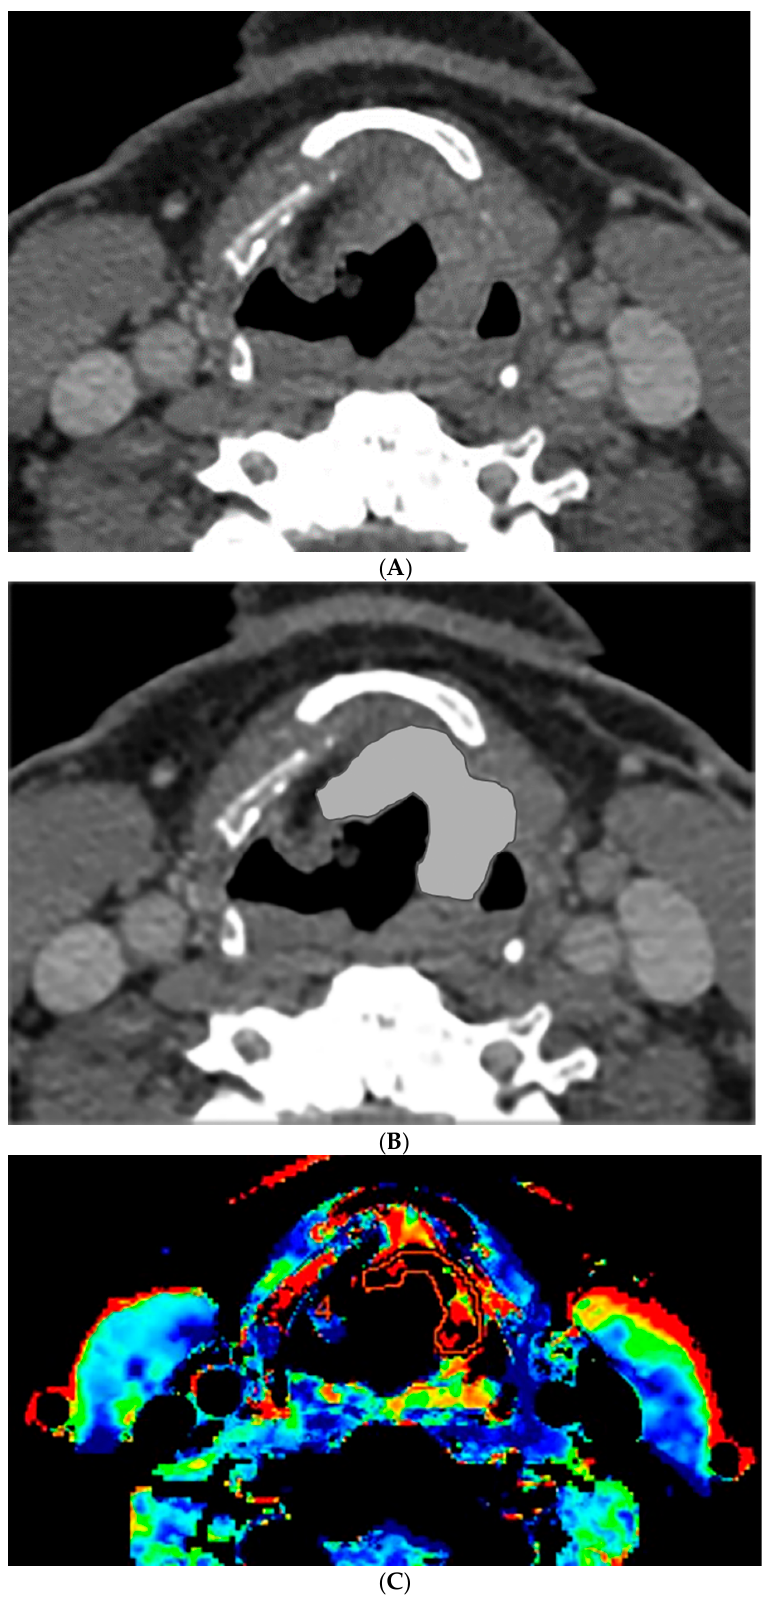
Figure 2. CT and perfusion sections of laryngeal carcinoma on post-treatment images. Axial sections show the grayscale image ( A ) and outlines for the following: computer ( B ) and perfusion ( C